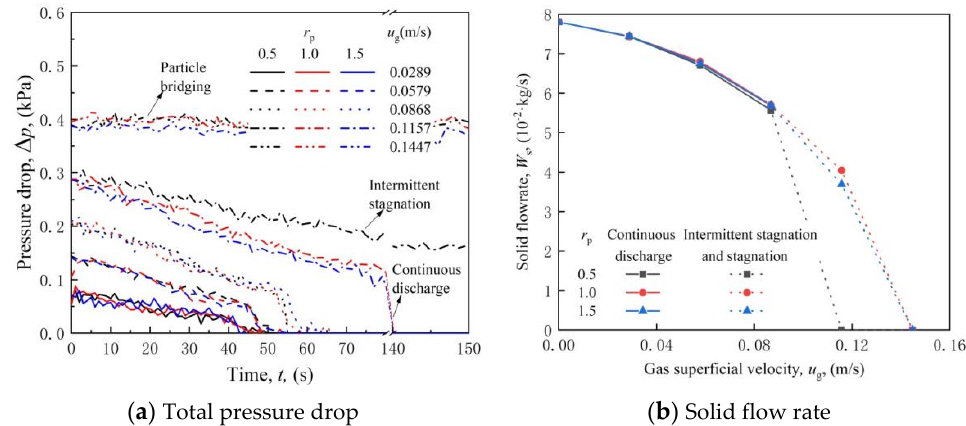
Figure 4. Time variations of total pressure drop and solid flow rate under different ratio of position of gas distributor to bed width r p and gas superficial velocity u g conditions ( D 0 = 15 mm, α = 0°).